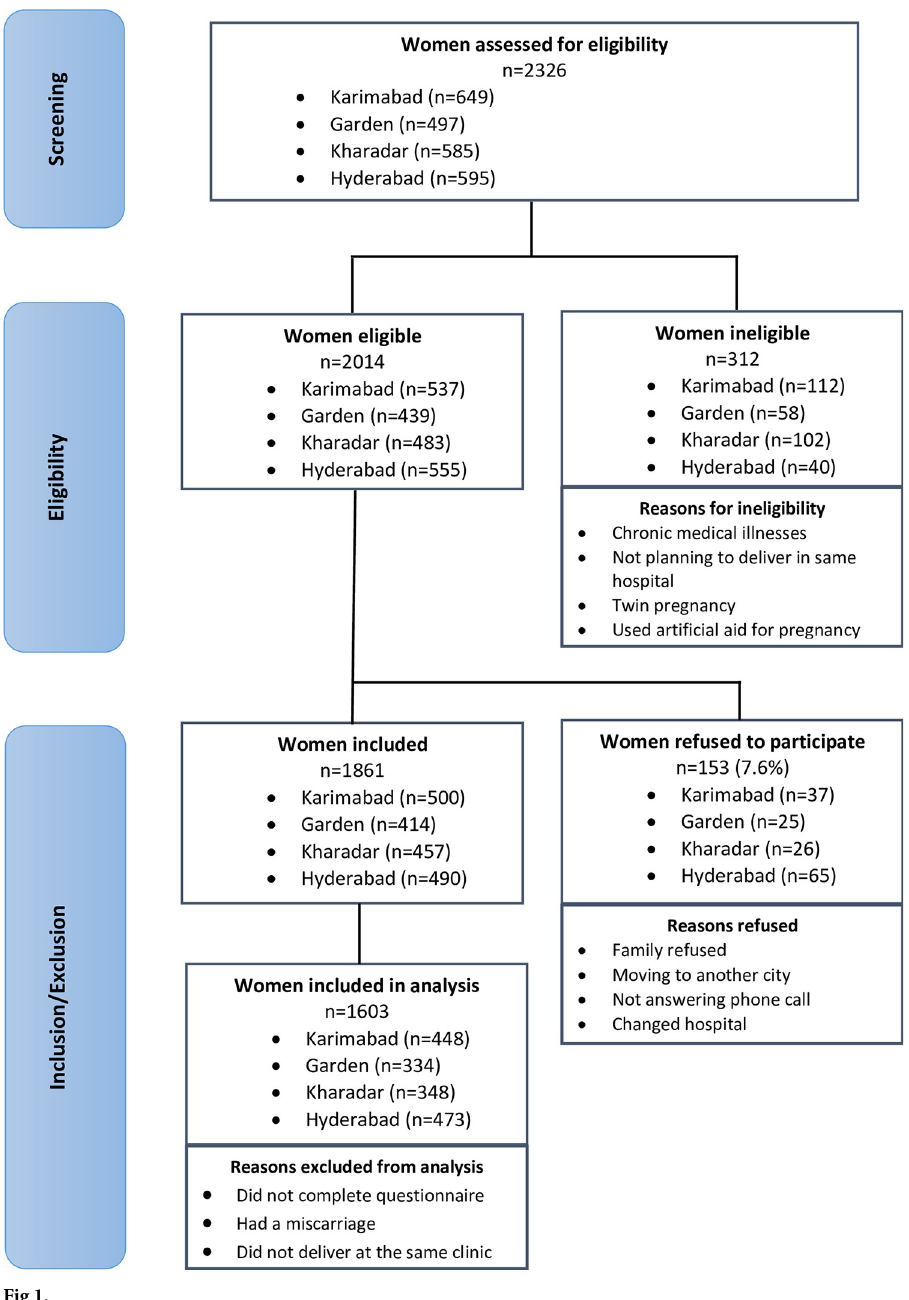
change in the predictor variable was 1404 assuming a squared multiple correlation of 0.15. To account for estimates of potential loss to follow-up and missing data, we overenrolled for a total sample of 1861. Missing data arose only for enrolled women who (a) did not deliver at the same clinic and who thus were excluded as they did not meet our inclusion criteria, or (b) had a miscarriage thus were excluded given our definition of preterm birth ( � 22 and < 37 weeks’ gestational age).